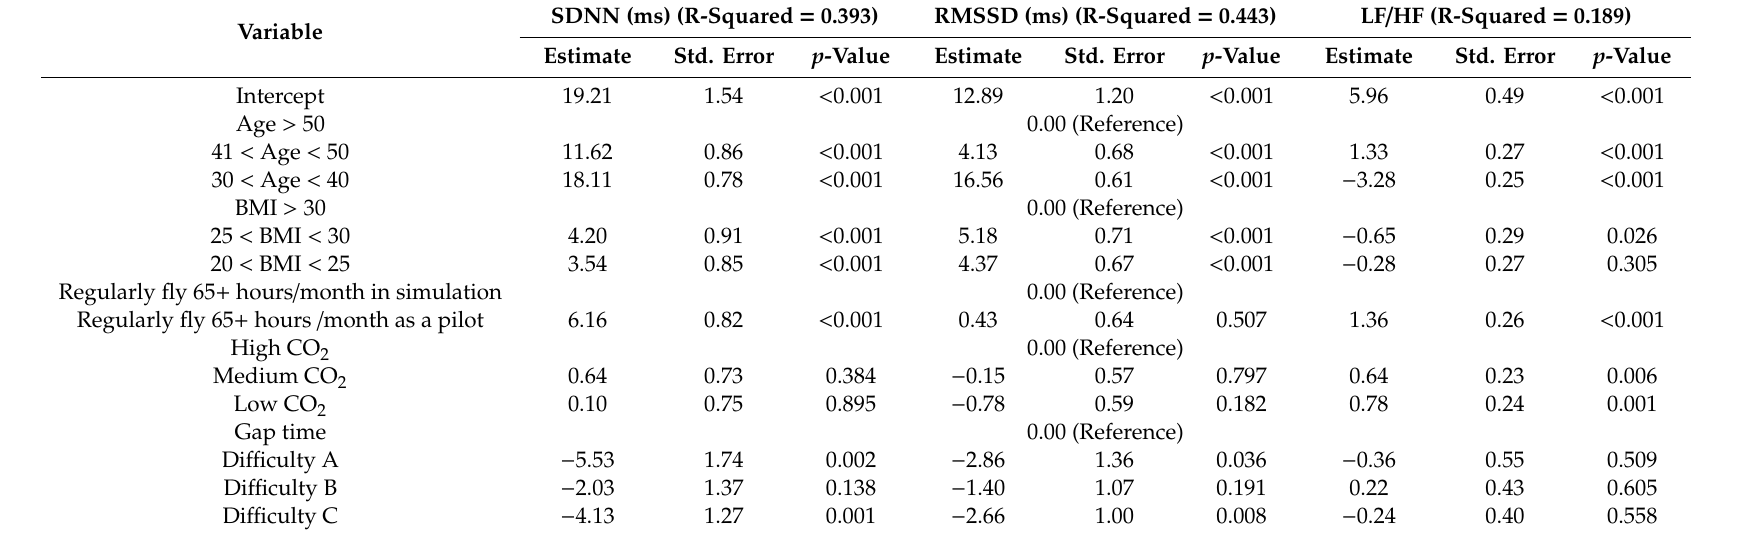
Table 3. The fixed e ff ect estimates on HRV indices, controlling for examiner and flight profile